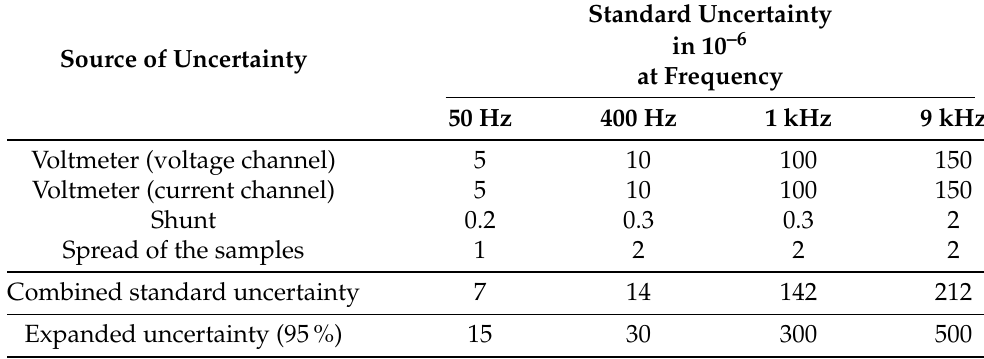
Table 4. Uncertainty of the apparent power.